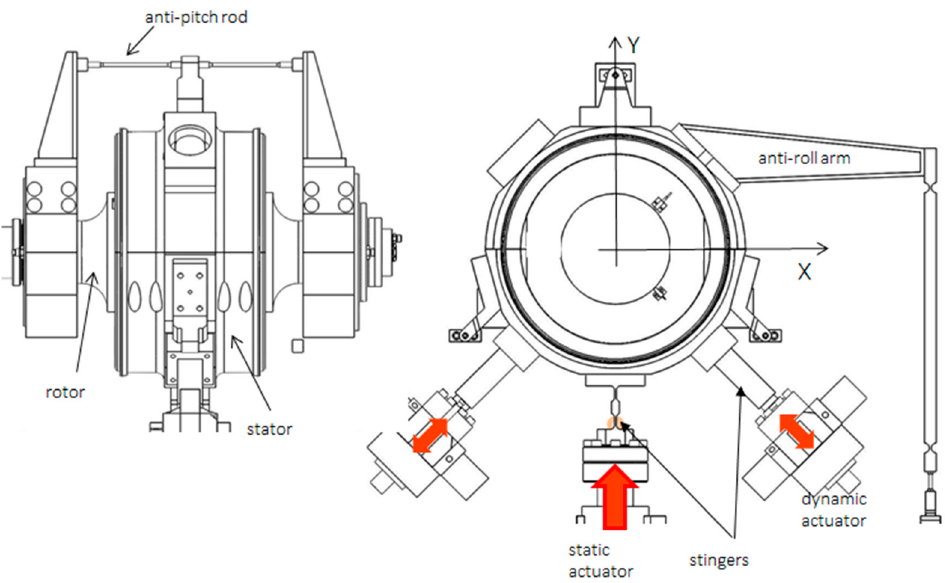
Figure 2. Drawing of the test cell. Table 1. Main characteristics of the experimental